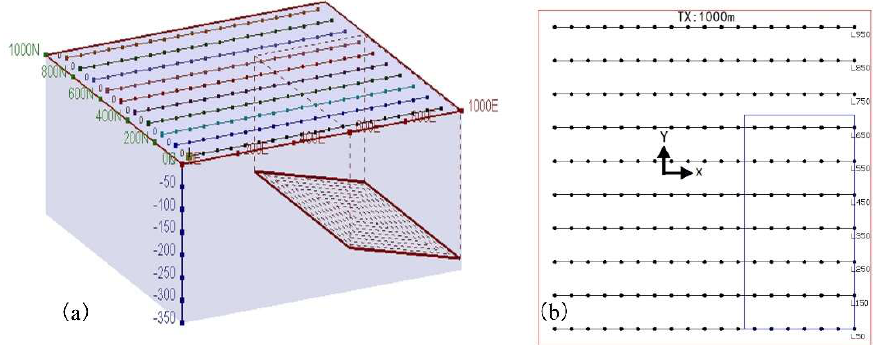
Figure 2. 3D forward model of the fixed loop: ( a ) 3D forward model, ( b ) plan for 3D model.